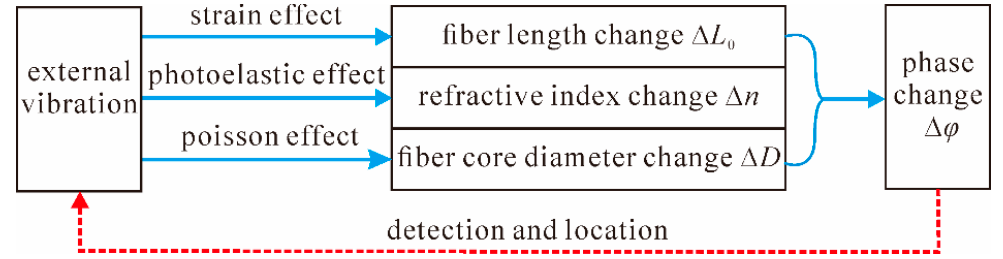
Figure 1. Schematic diagram of the detection principle of distributed fiber-optic interferometric vibration sensors.